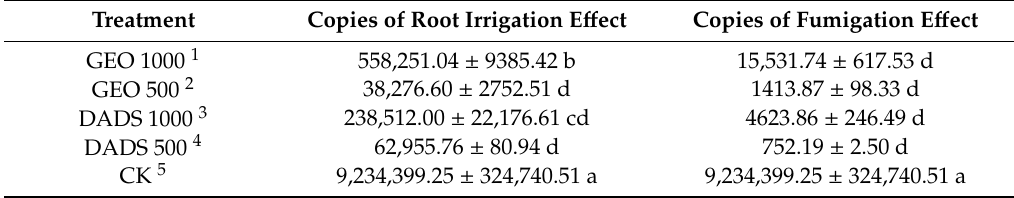
Table 3. DNA copies of P. nicotianae treated with garlic essential oil and